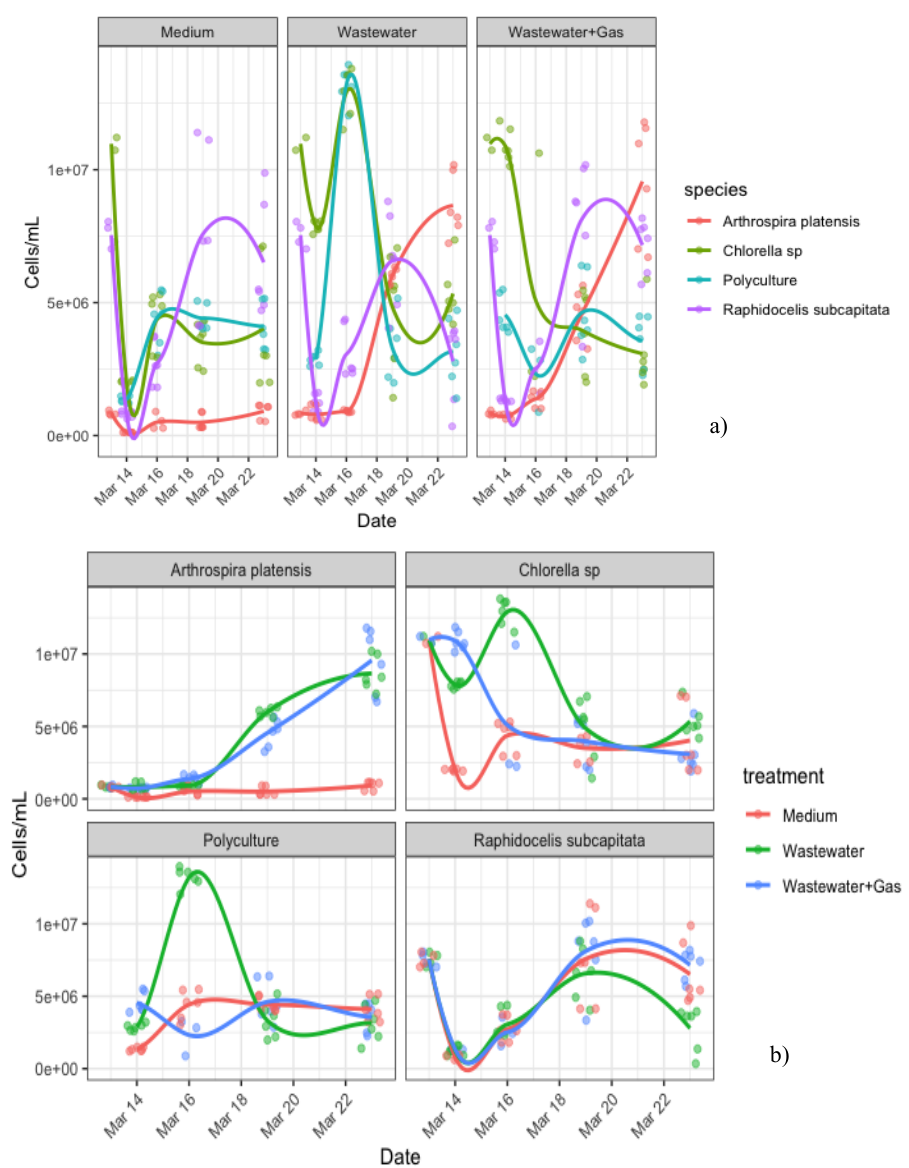
Fig. 1. Cell concentration grouped by: a) treatment, b)